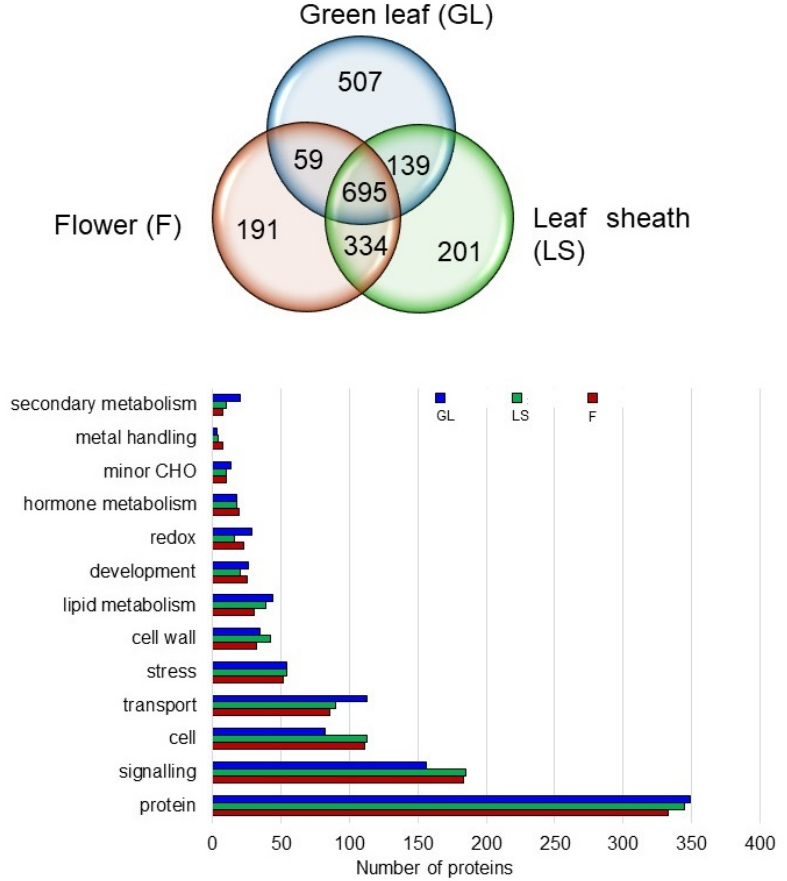
Figure 6. Functional categories and Venn diagram showing the number of common and organ-specific proteins in the plasma membrane fractions of the leaf sheath (LS), flower (F), and green leaf (GL) in rice. The plasma membrane proteins were functionally categorized using the MapMan bin codes. Category “cell” contains cell organization, cell division, cell cycle, and vesicle transport. Category “protein” comprises protein degradation/synthesis/targeting/PTM/amino acid activation/folding.